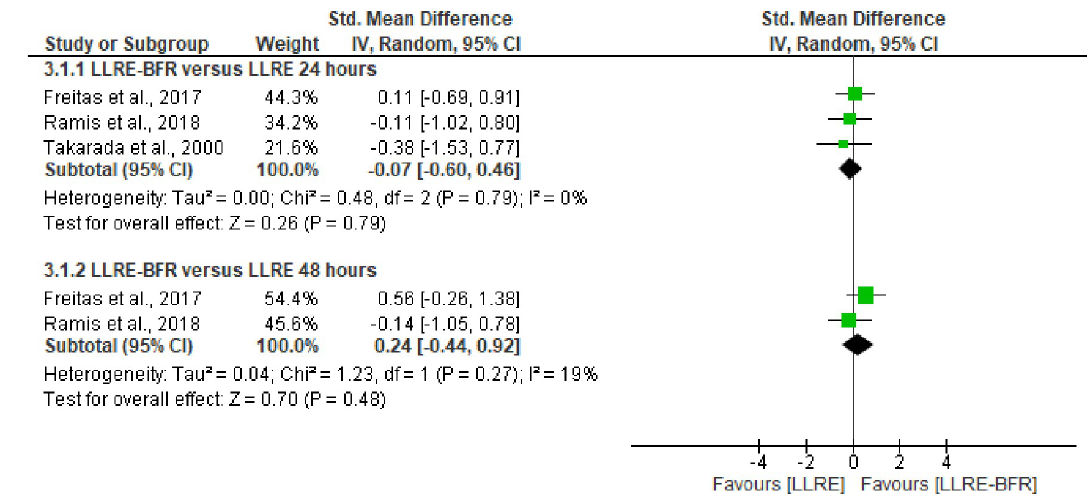
Fig 3. Forest plot about effects of LLRE-BFR versus LLRE on biomarkers of damage to lipids 24 hours and 48 hours post- exercise. LLRE-BFR: Low load resistance exercise with blood flow restriction; HLRE: High-load resistance exercise, LLRE: Low load resistance exercise; SMD: Standardized mean difference; SD: Standard deviation; IV: Inverse variance; CI: Confidence interval.